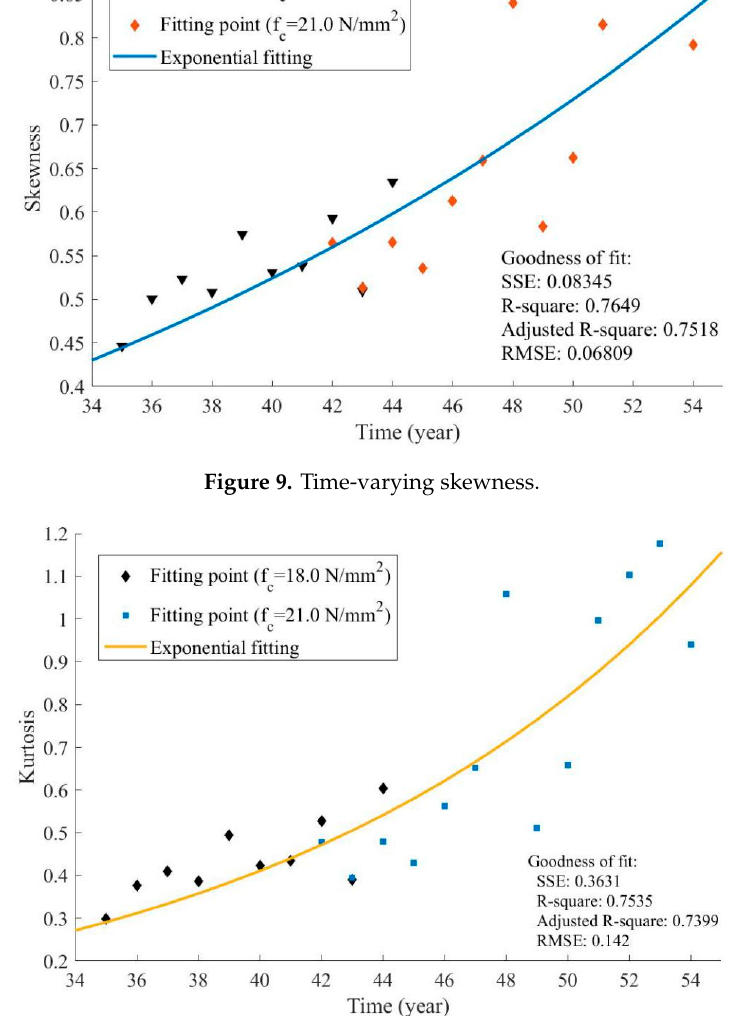
Figure 10. Time-varying kurtosis.